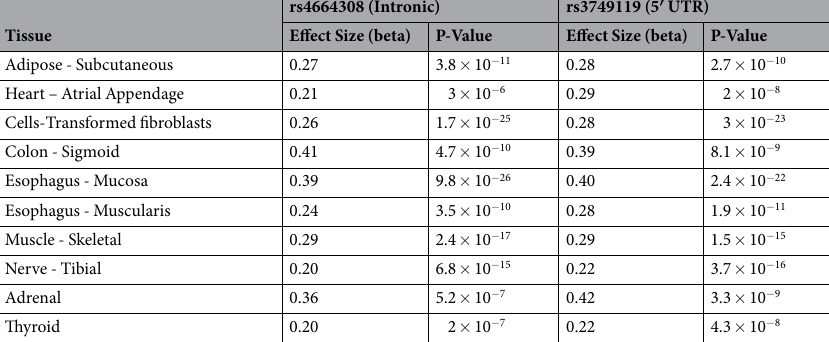
Table 4. Expression quantitative trait loci (eQTL) information for rs4664308 (intronic) and rs3749119 (5 ′ UTR) SNPs from Genotype-Tissue expression (GTEx) database. Both are strongly associated with PLA2R1 expression levels in multiple